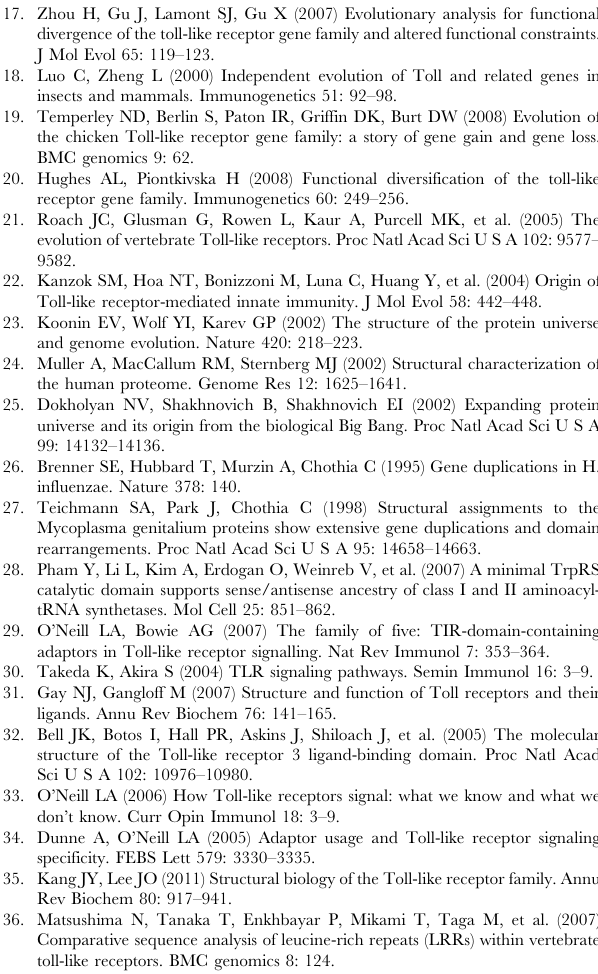
sapiens interleukin 1 receptor. The numbers indicate boot-strap support out of 1000. Only value above 500 are indicated. (TIFF) Figure S2 Maximum likelihood phylogeny of the TIR domain of the TLR family alone. The tree is rooted by the outgroup TIR domain Homo sapiens MyD88. The numbers indicate boot-strap support out of 1000. Only value above 500 are indicated. (TIFF) Figure S3 Minimum evolution phylogeny of the TIR domain of the TLR family alone. The tree is rooted by the outgroup TIR domain Homo sapiens MyD88. The numbers indicate boot-strap support out of 1000. Only value above 500 are indicated. (TIFF) Figure S4 Maximum likelihood phylogeny of the TLR family reconstructed from the complete amino acid sequence. The tree is rooted by the outgroup Nicotiana glutinosa N. The numbers indicate boot-strap support out of 1000. Only value above 500 are indicated. (TIFF) Figure S5 Minimum evolution phylogeny of the TLR family reconstructed from the complete amino acid